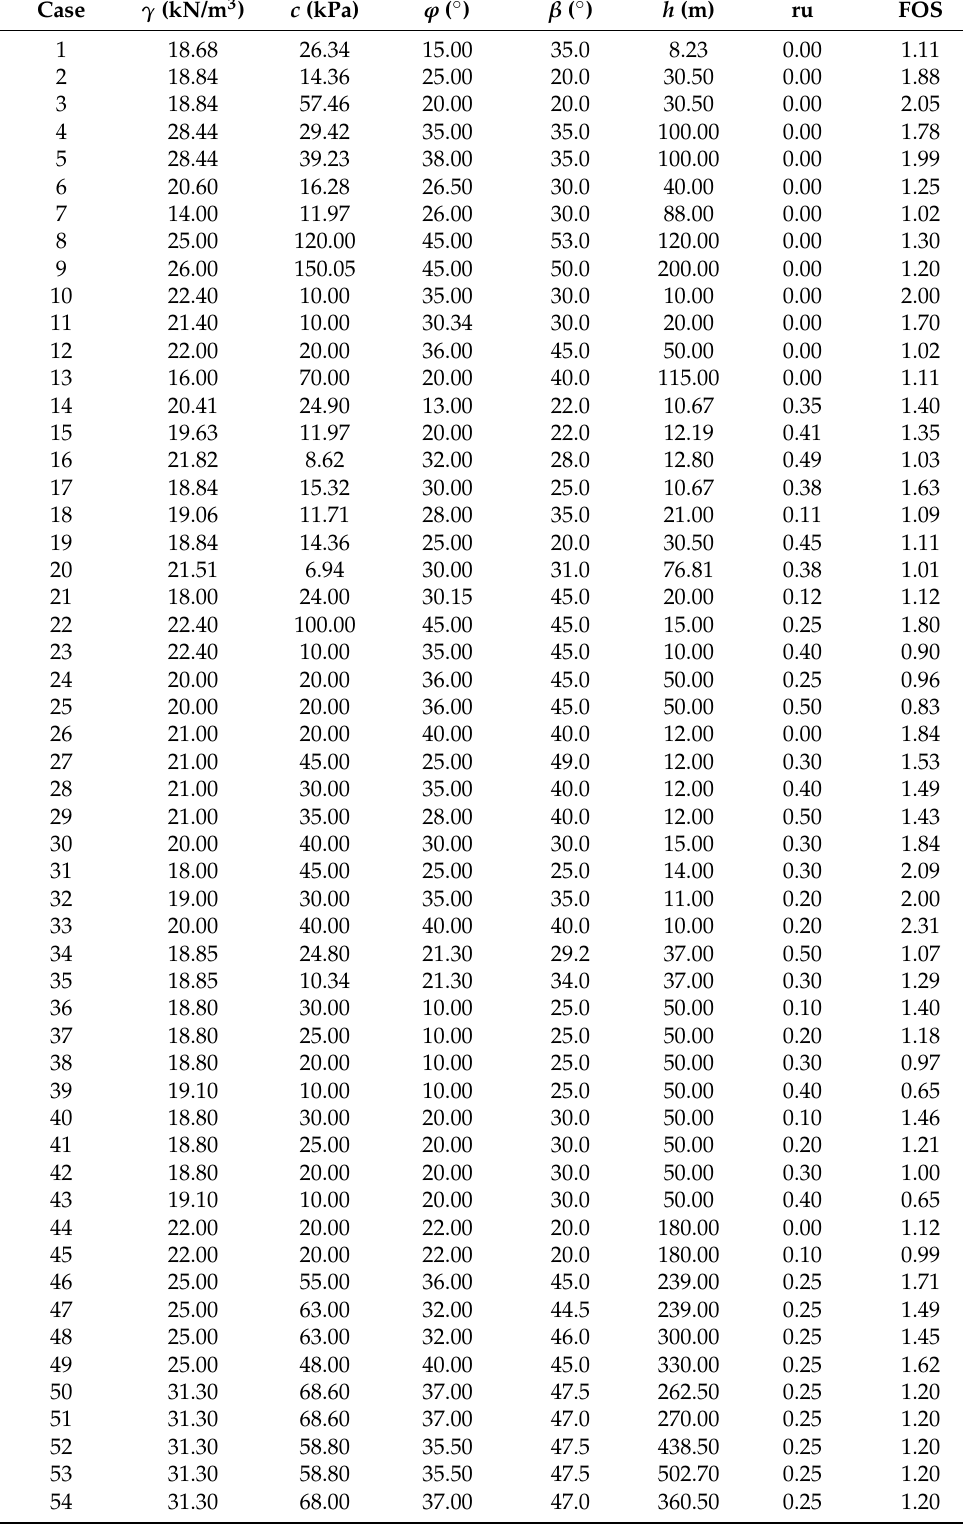
Table 1. Database for training the machine learning